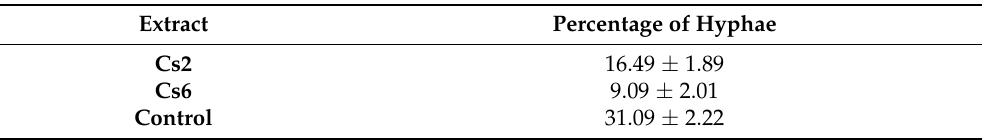
Table 8. Percentage of hyphal cells calculated by comparison with the total number of C. albicans cells. Values are means ± SD of three replicates.